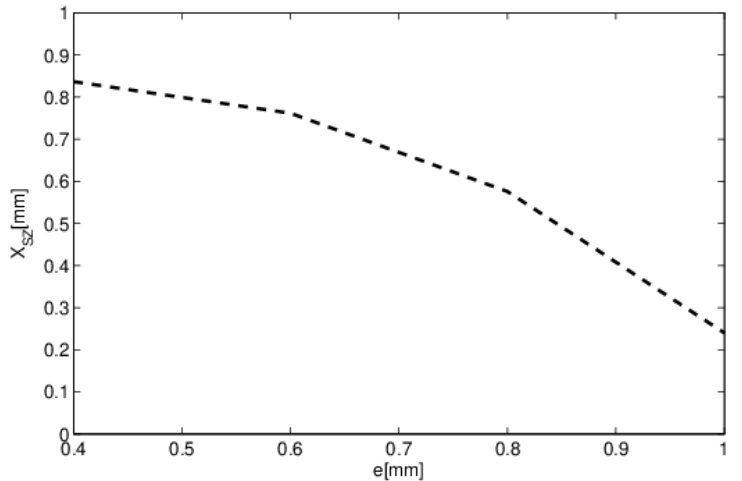
Figure 17. Evolution of stagnation zone with PTFE substrate thickness. (t = 1 s, θ = 90 ◦ , V 0 = 1 mm 3 ,